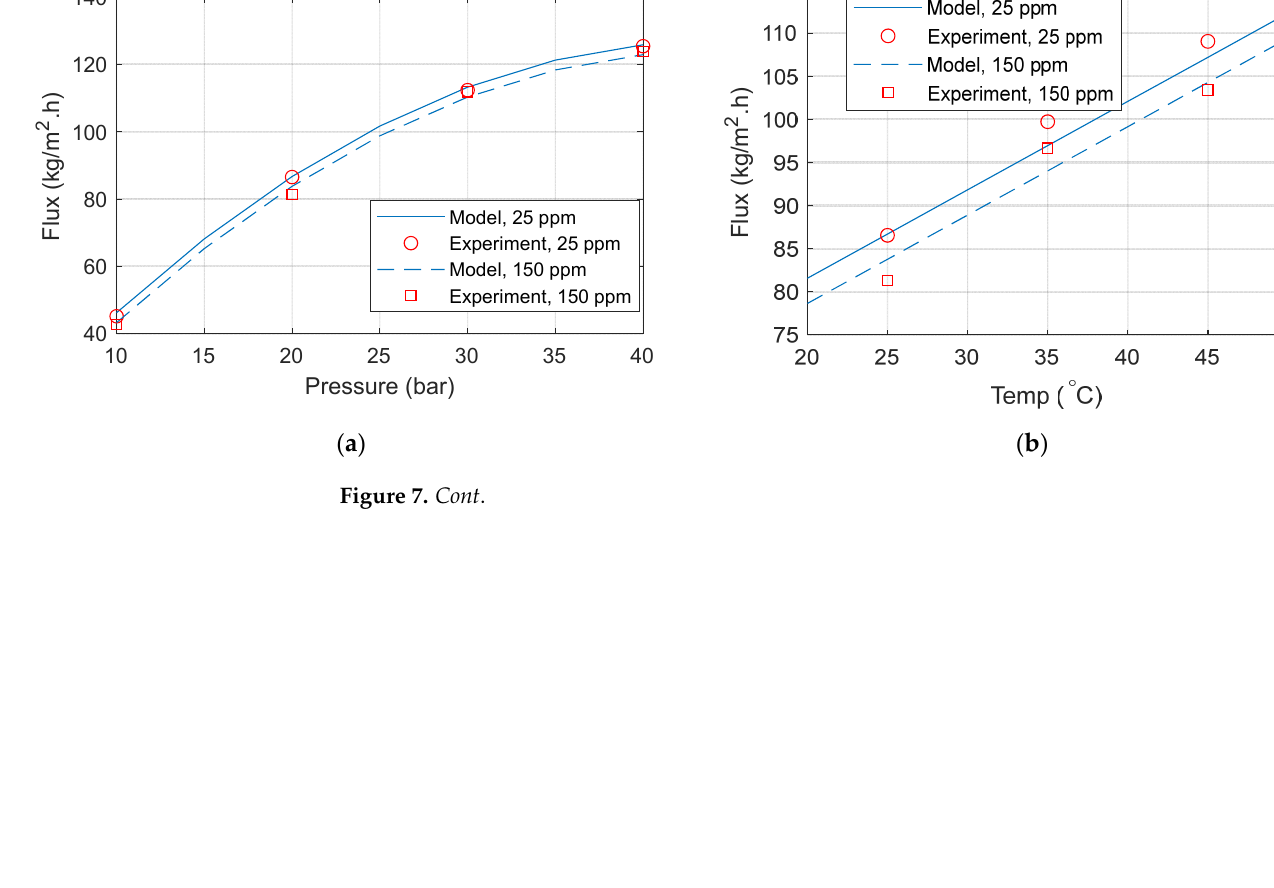
Figure 7. Permeate flux comparison between model and experimental data for various ( a ) pressure ( b ) temperature ( c ) concentration ( d ) flow rate. 3.6.2. Copper Removal Model The removal percentage is calculated using Equation (2). It has been noted that C p is the only parameter to be modeled in Equation (2) since C F is pre-known. By following the same approach used for the permeate flux model, a model for copper removal % was developed. The relationship functions are given in Table 5. Table 5. Relationship function between concentration in permeate ( C p ) and the parameters. Permeate Flux vs. Relationship Function